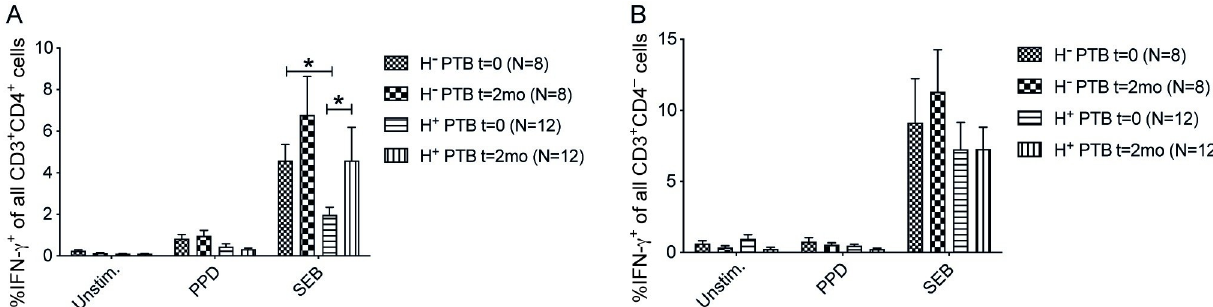
Fig 5. IFN- γ producing capacity of CD4 + T cells enhanced in helminth positive PTB at the two months of TB and anti-helminthic treatment follow- up. Anti-TB drugs were administered to all PTB patients and helminth positive patients (H + PTB) received additional anti-helminthic treatment. Unstimulated, PPD and SEB stimulated PBMCs were ex vivo incubated with Brefeldin A to analyze intracellular IFN- γ expression in CD3 + CD4 + and CD3 + CD4 - T cells by flow cytometry. Frequency of IFN- γ + CD4 + T cells of all CD3 + CD4 + cells (A) and frequency of IFN- γ + CD4 - T cells of all CD3 + CD4 - cells (B) in helminth negative PTB (H - PTB) and combined (H + PTB) PTB patients. Data presented as mean ± SEM, and two-way ANOVA with Bonferroni posttest used to assess differences between groups. � , p < 0.05.